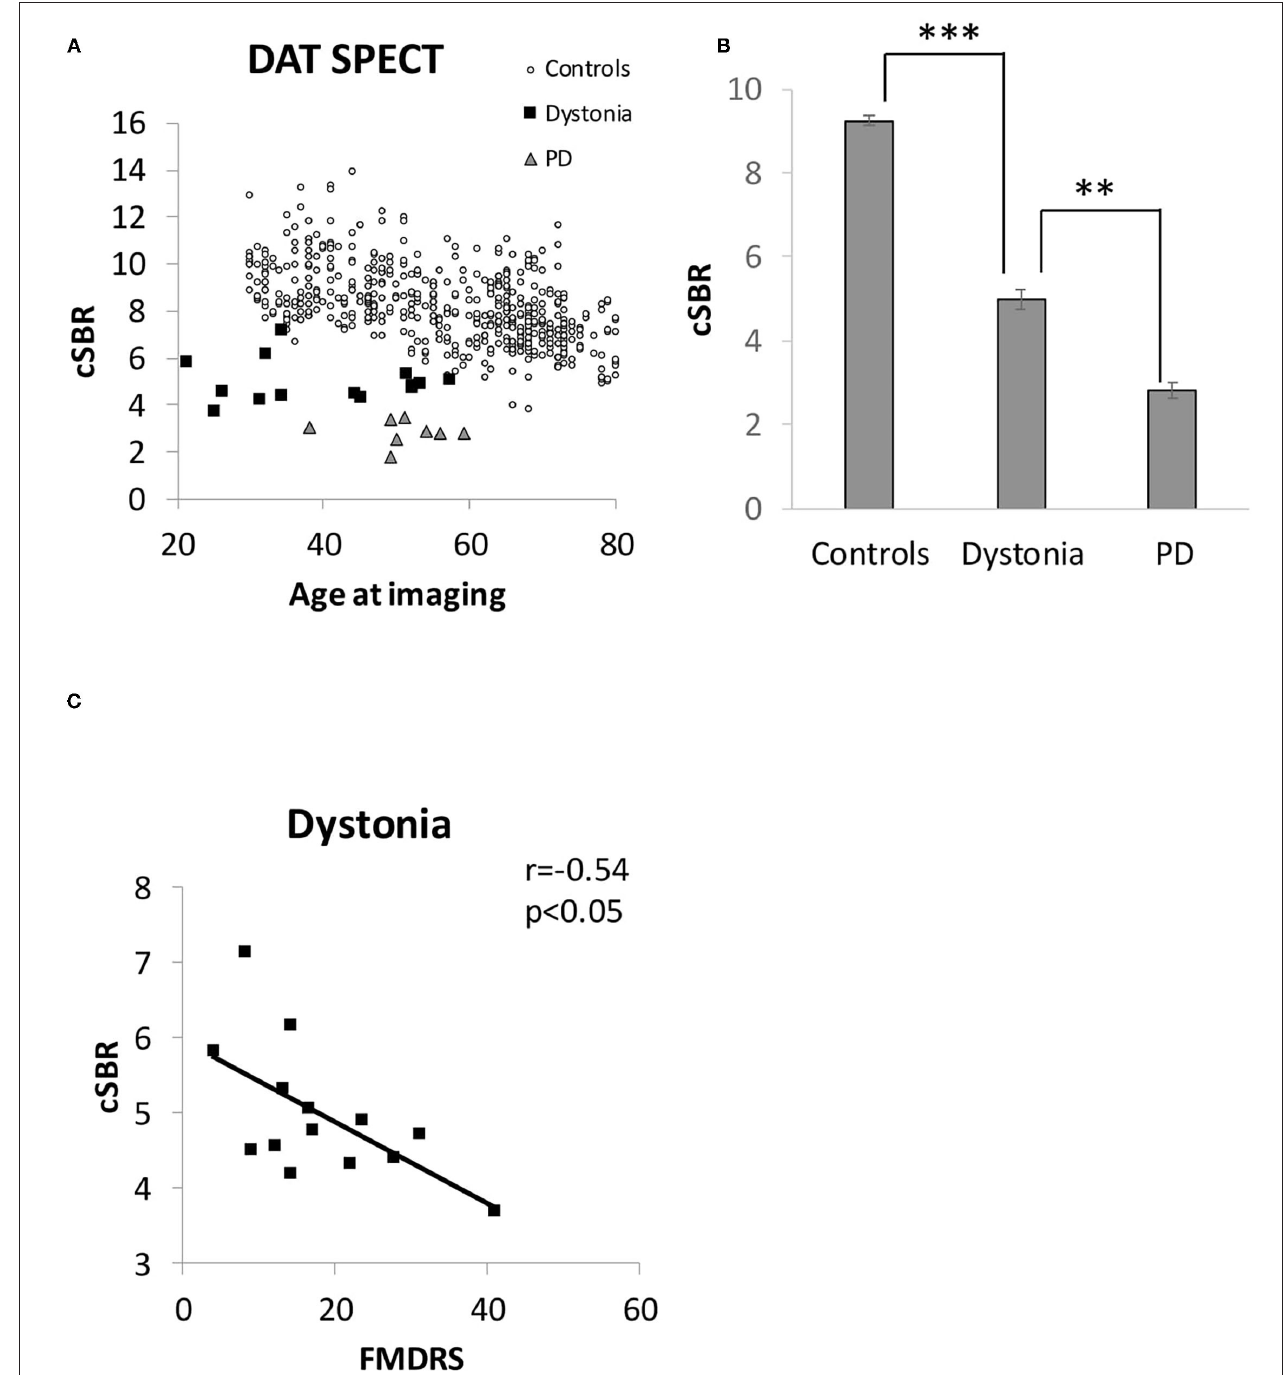
FIGURE 4 | (A) Distribution of the cSBR in patients with dystonia, patients with PD, and healthy controls. The control group was obtained from a database of Japanese healthy volunteers ( n = 256). (B) Comparison of the cSBR between patients with dystonia, patients with PD, and healthy controls. The participants in the control group were extracted from the Japanese database to match the mean age of the dystonia group ( n = 89, 30–50 years) for comparison with that group. (C) Correlation between the FMDRS and the cSBR of patients with dystonia. Error bars indicate SEM. **Statistically significant difference ( p < 0.5 x 10 − 6 ). ***Statistically significant difference ( p < 0.5 x 10 − 22 ). cSBR, calibrated specific binding ratio; FMDRS, Fahn-Marsden Dystonia Rating Scale; PD, Parkinson’s disease; SEM, standard error of the mean.